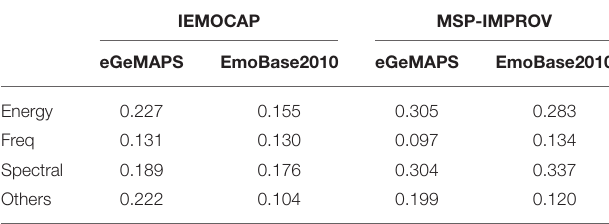
TABLE 5 | The averaged correlation between the first principal component vector and different types of acoustic feature categories. IEMOCAP MSP-IMPROV eGeMAPS EmoBase2010 eGeMAPS EmoBase2010 Energy 0.227 0.155